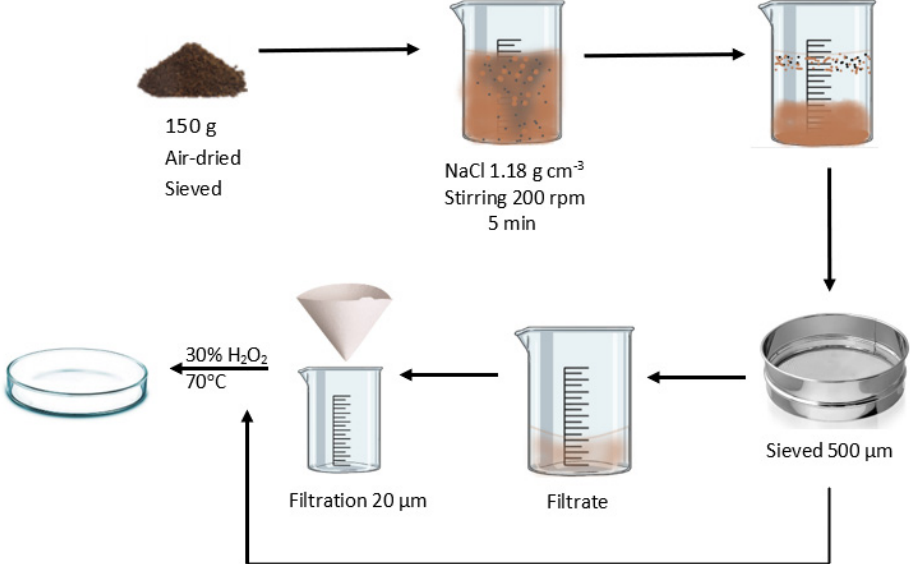
Figure 1. Schematic representation of the MPs extraction procedure by NaCl floatation.